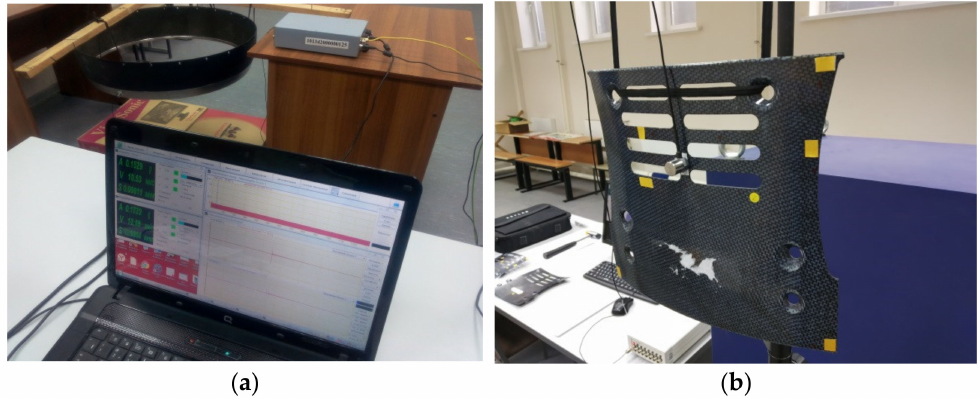
Figure 3. Determination of natural frequencies of the separator ( a ) and panel ( b